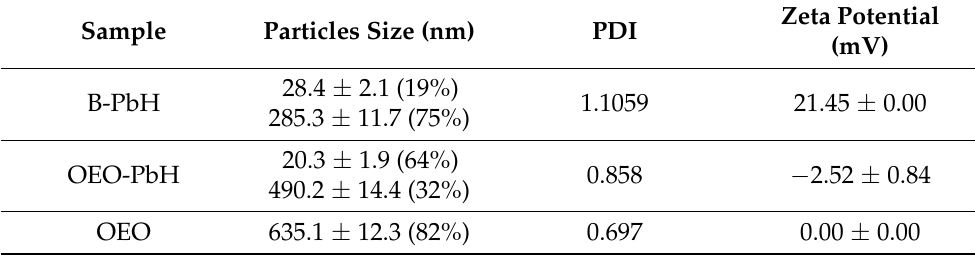
Table 3. Size and zeta potentials